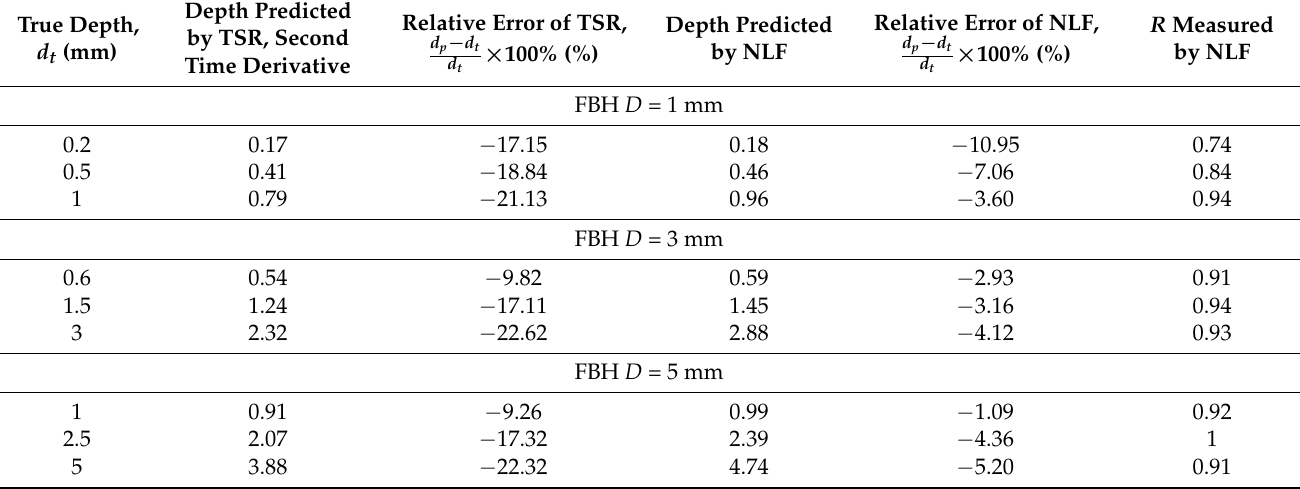
Table A1. Mean relative error of depth estimation by using TSR and NLF techniques